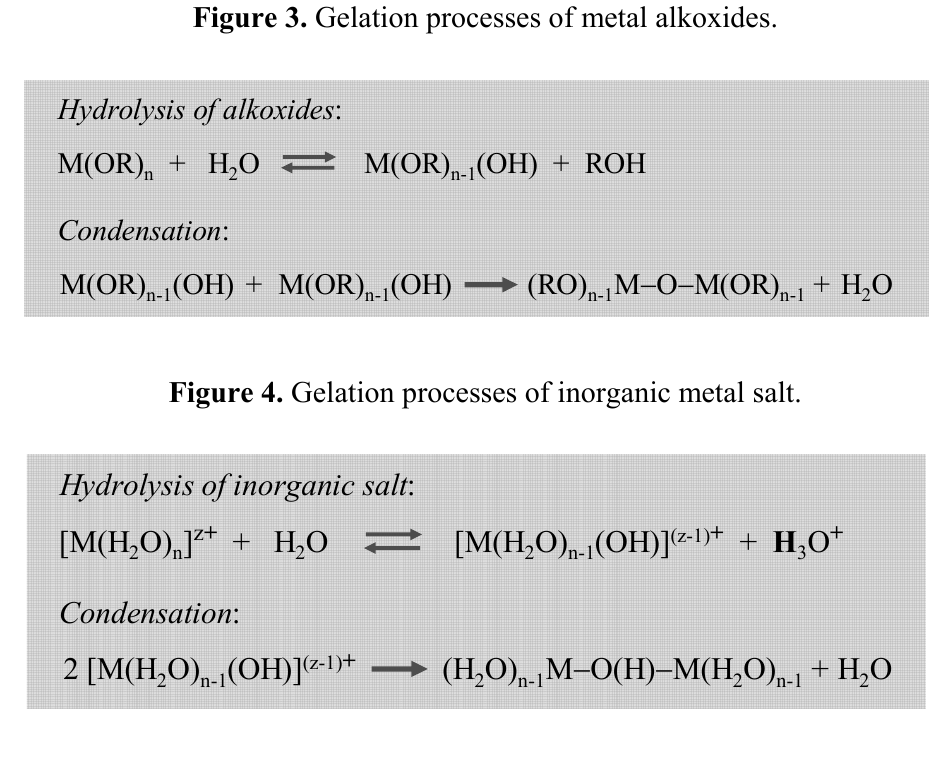
Figure 3. Gelation processes of metal alkoxides.